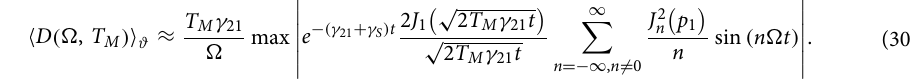
mated from Eq. (27) as